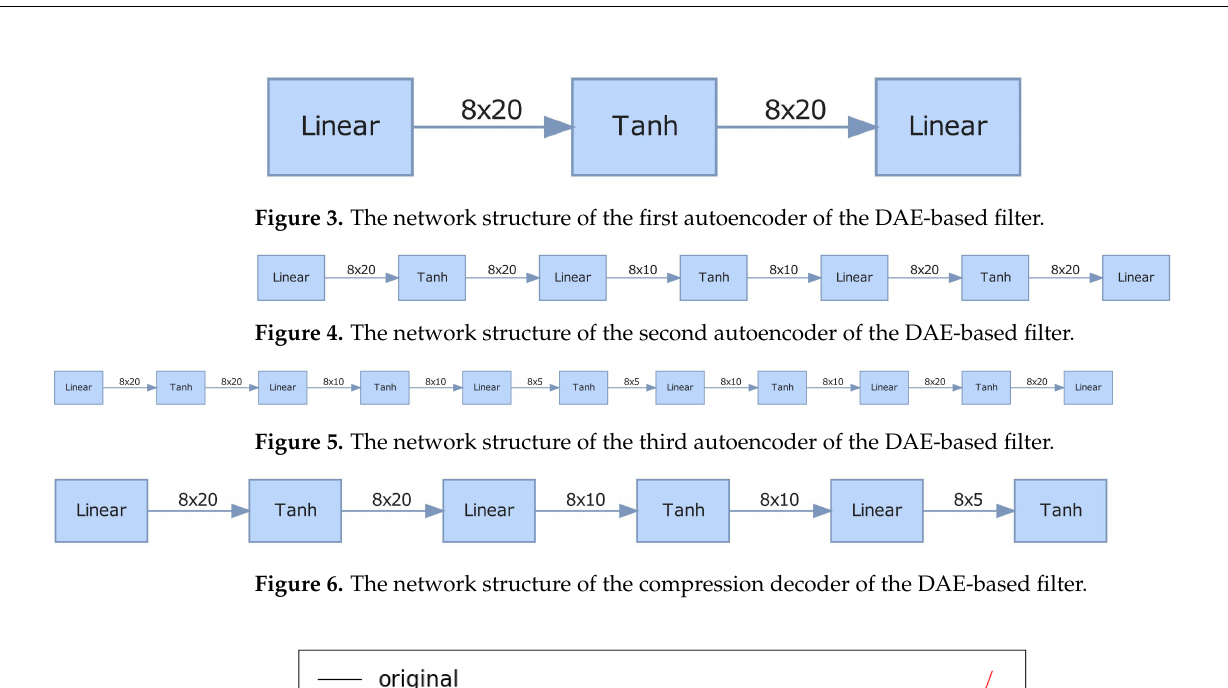
Figure 5. The network structure of the third autoencoder of the DAE-based filter.